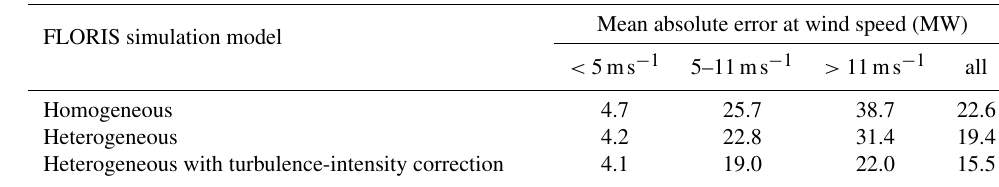
Table 2. Mean absolute error in total wind farm power output for all FLORIS models, tabulated for comparison within varying ranges of wind speeds. Total rated wind farm output was scaled to 100MW for reference.